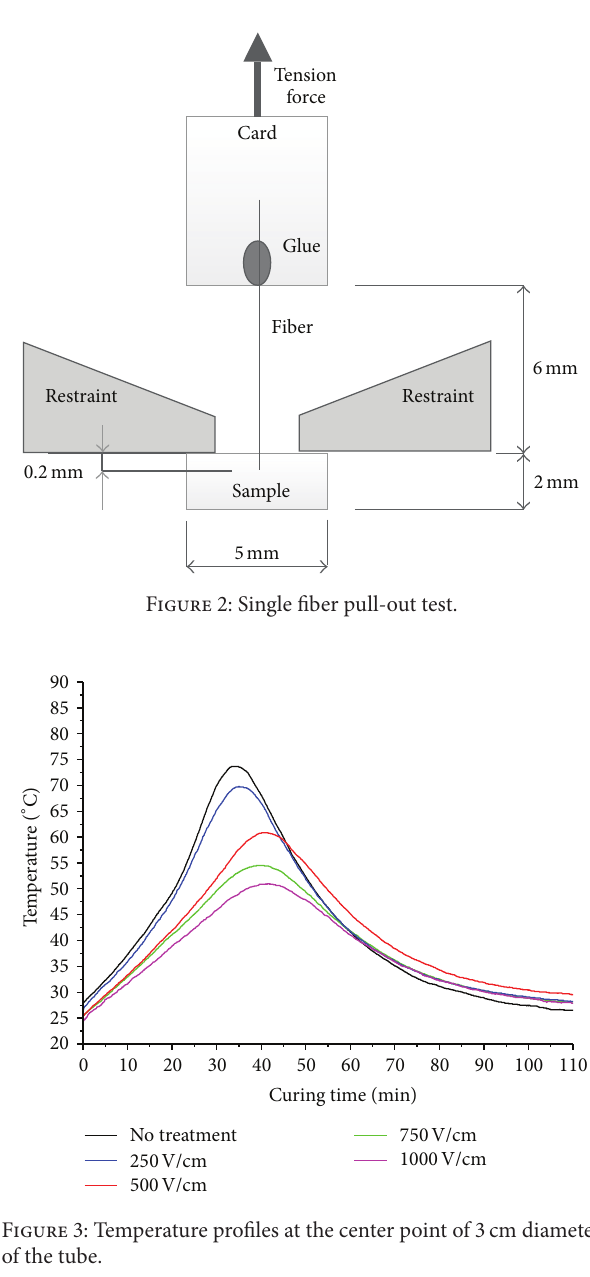
Figure 3: Temperature profiles at the center point of 3 cm diameter of the